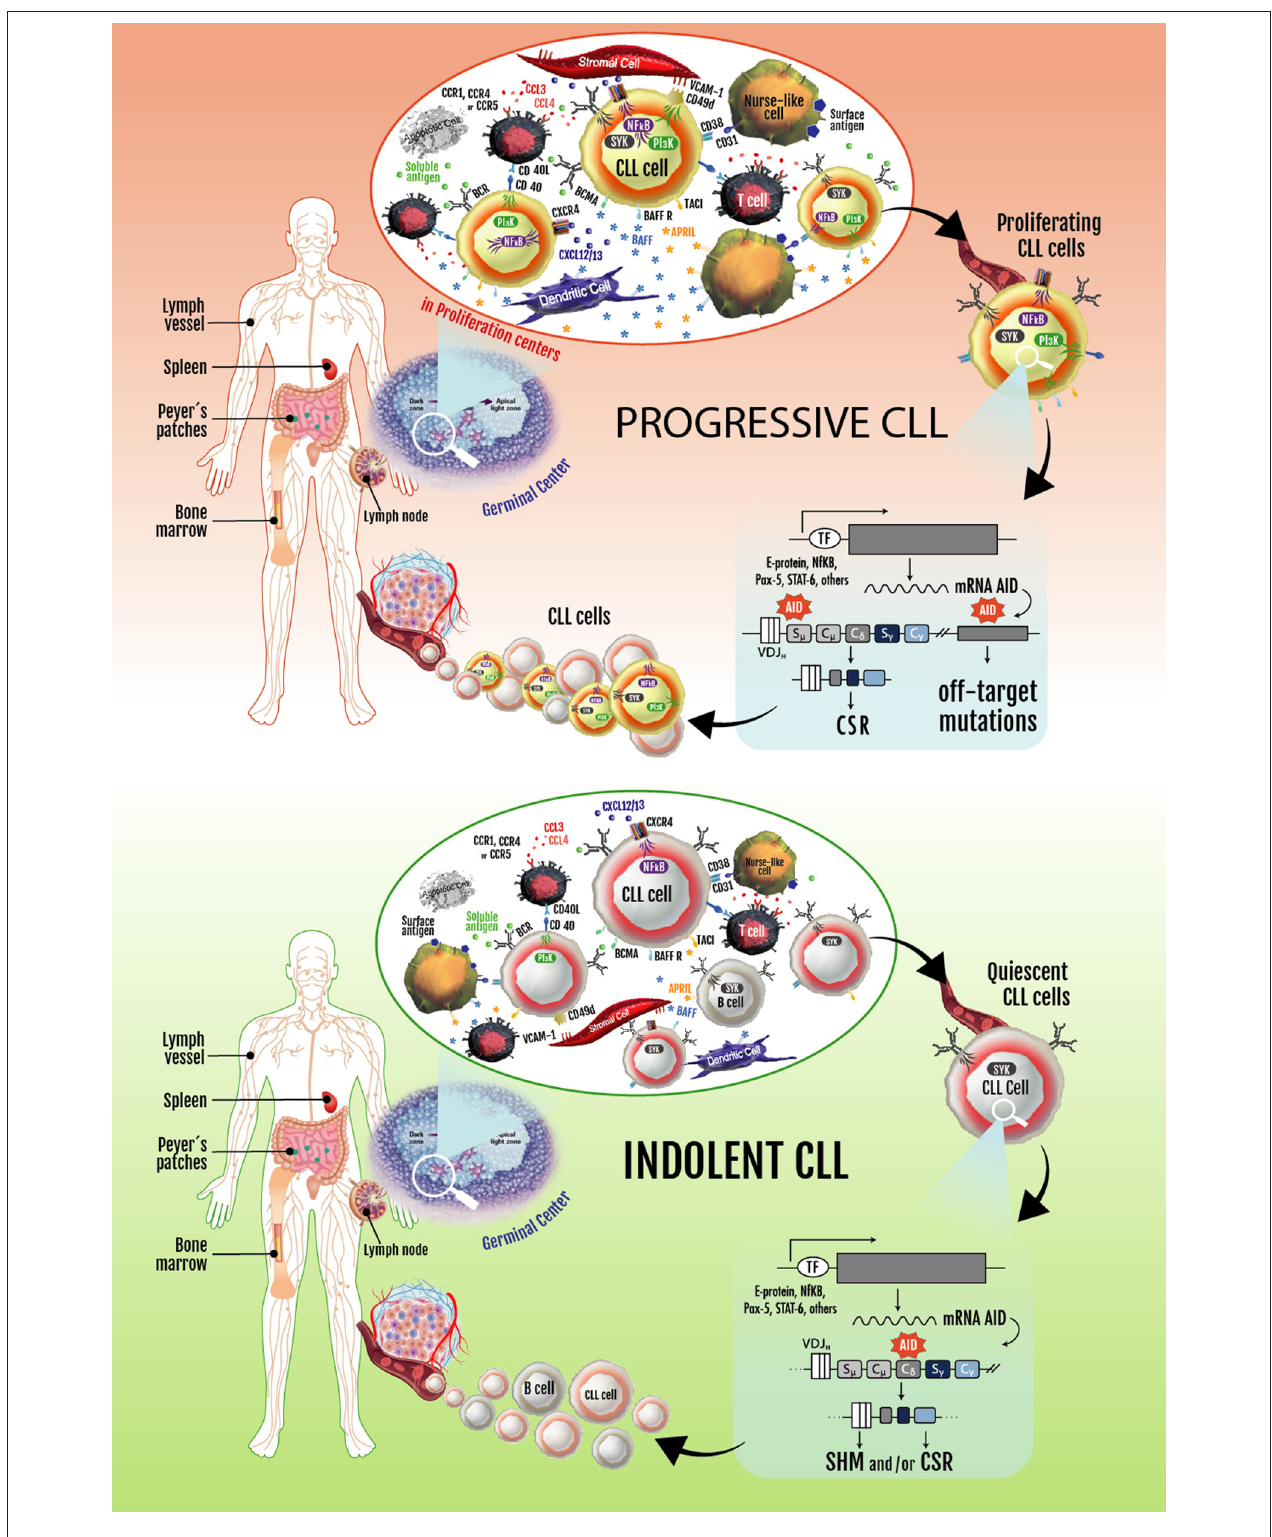
FIGURE 2 | Progressive and indolent CLL landscapes based on microenvironmental influences. In patients with progressive disease, an activated microenvironment continuously nourishes leukemic cells by maintaining proliferative fractions that can express AID. Proliferating cells overexpressing AID are susceptible to novel